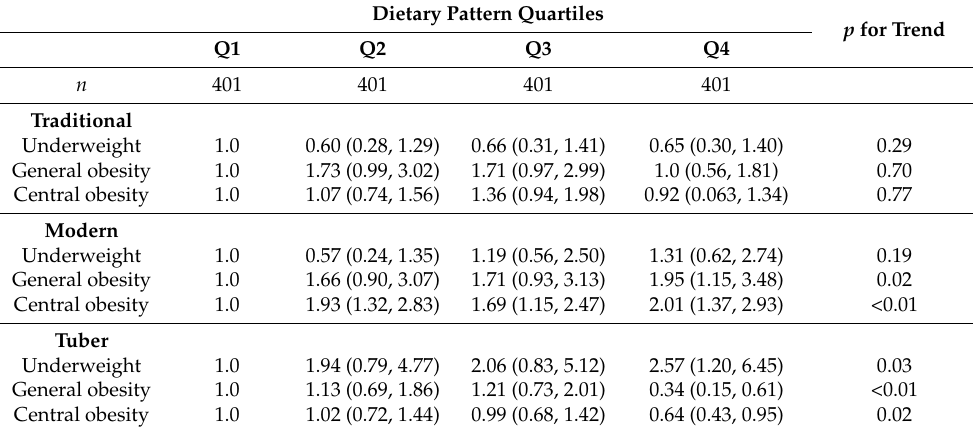
Dietary Pattern Quartiles